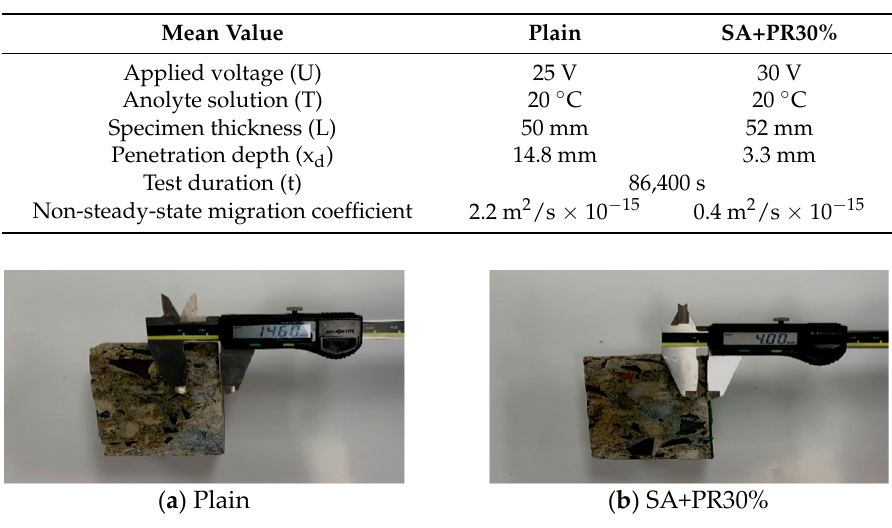
Table 5. Chloride migration test result.